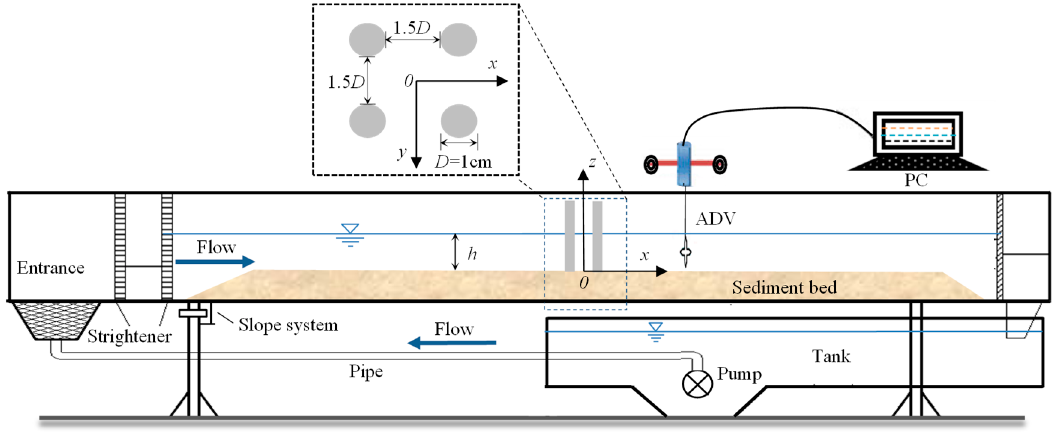
Figure 1. Experimental setup.